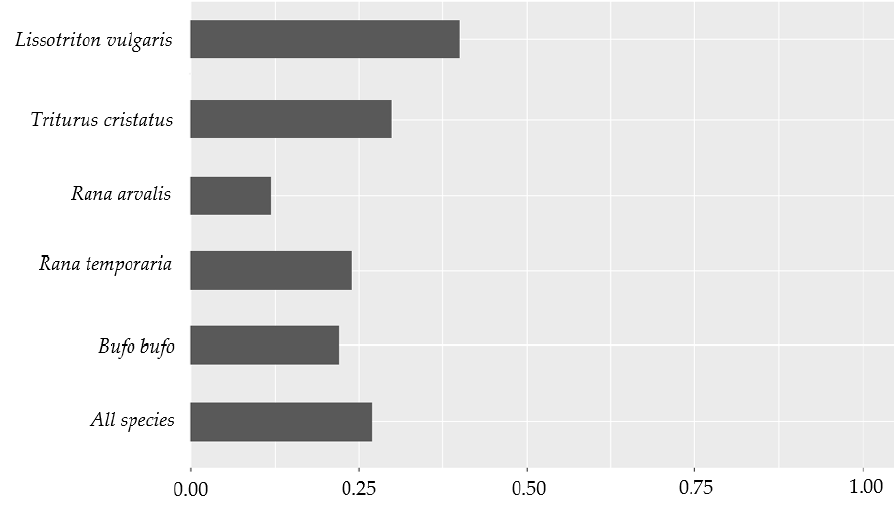
Figure 5. The similarity of observations between eDNA metabarcoding and conventional survey methods applied in the present study for all relevant species. The index value ranges from 0 to 1, where 0 indicates no similarity between the survey method and 1 indicates total similarity between the methods.